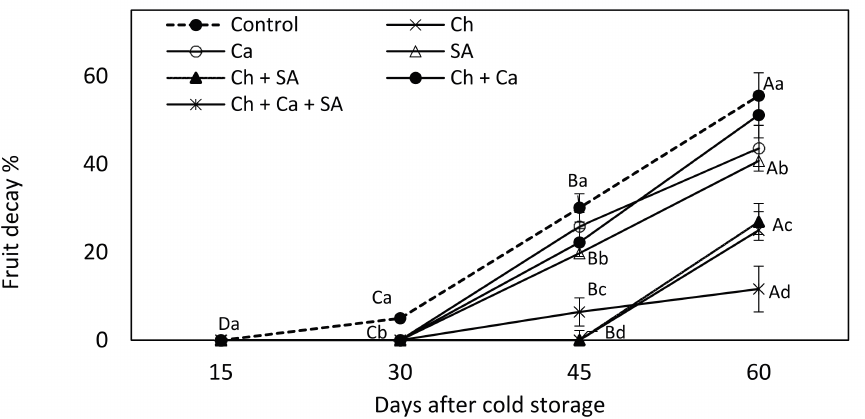
Figure 4. Effect of different preharvest treatments on ‘Khesab’ fruit decay during cold storage, values are the mean ( n = 25) ± SE. Means with different letters between treatments (small letter) at different time interval (capital letter) are significantly different at p < 0.05 using LSD test. Ch: chitosan; Ca: calcium chloride; SA: salicylic acid.